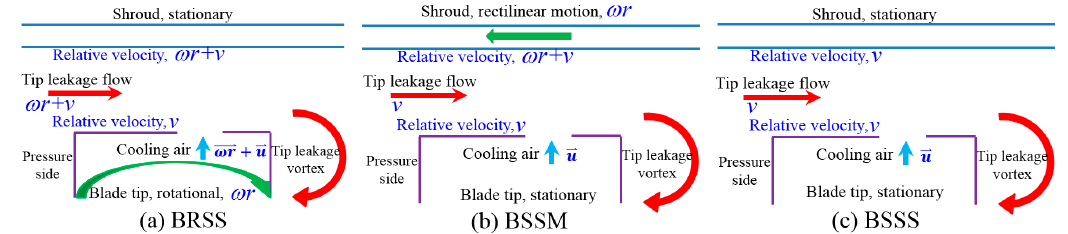
Figure 8. Comparison of the kinetic models: ( a ) BRSS; ( b ) BSSM; ( c ) BSSS.